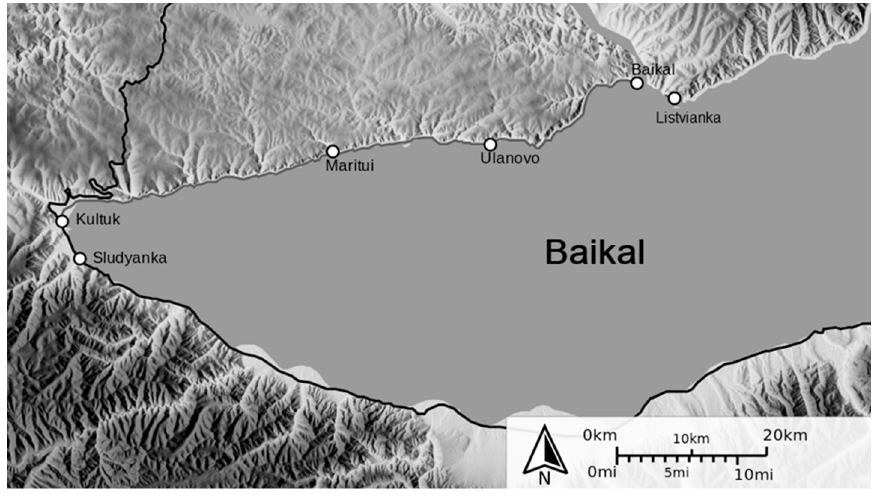
Figure 7. Sediment sampling sites.